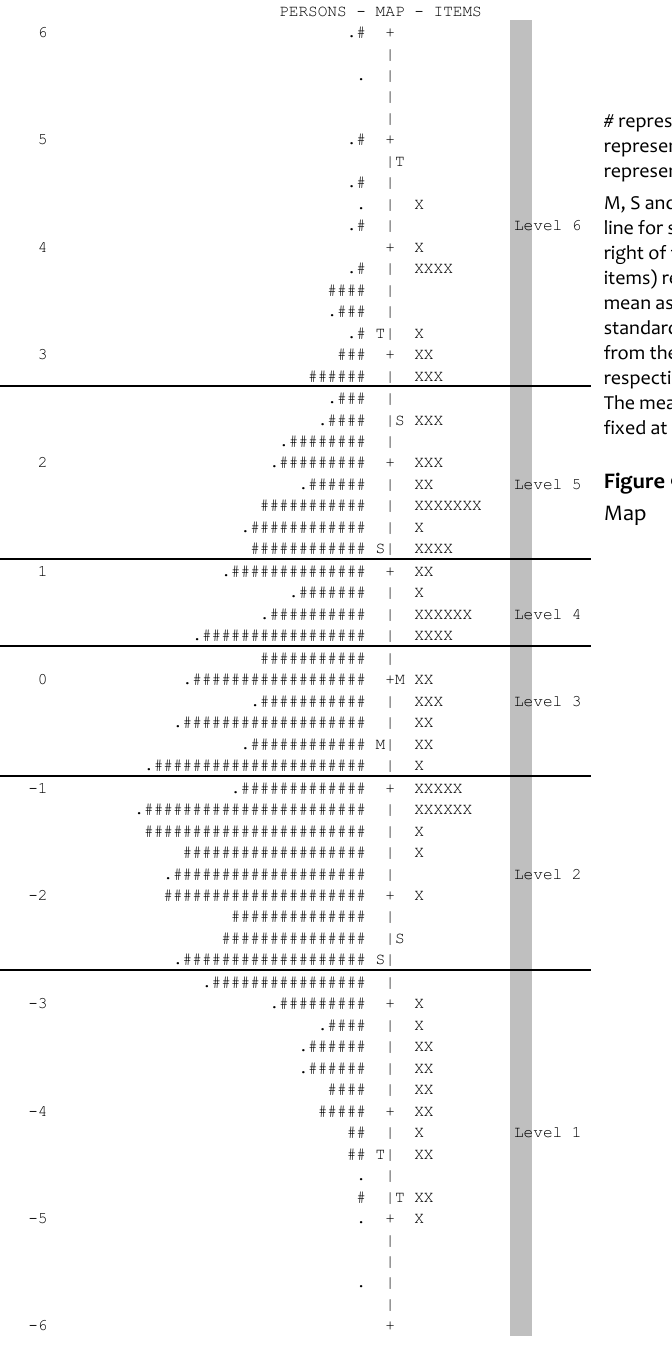
Figure 9: Person/Item